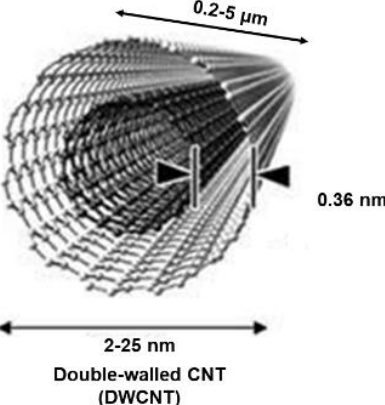
Figure 8. Structures of a DWCNT. This image by unknown author are licensed under CC BY.